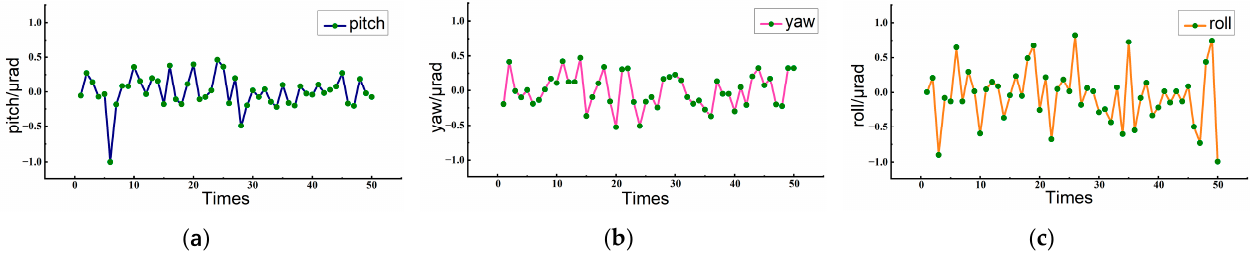
Figure 7. Noise evaluation experiment: ( a ) measurement results of pitch, ( b ) measurement results of yaw, ( c ) measurement results of roll.